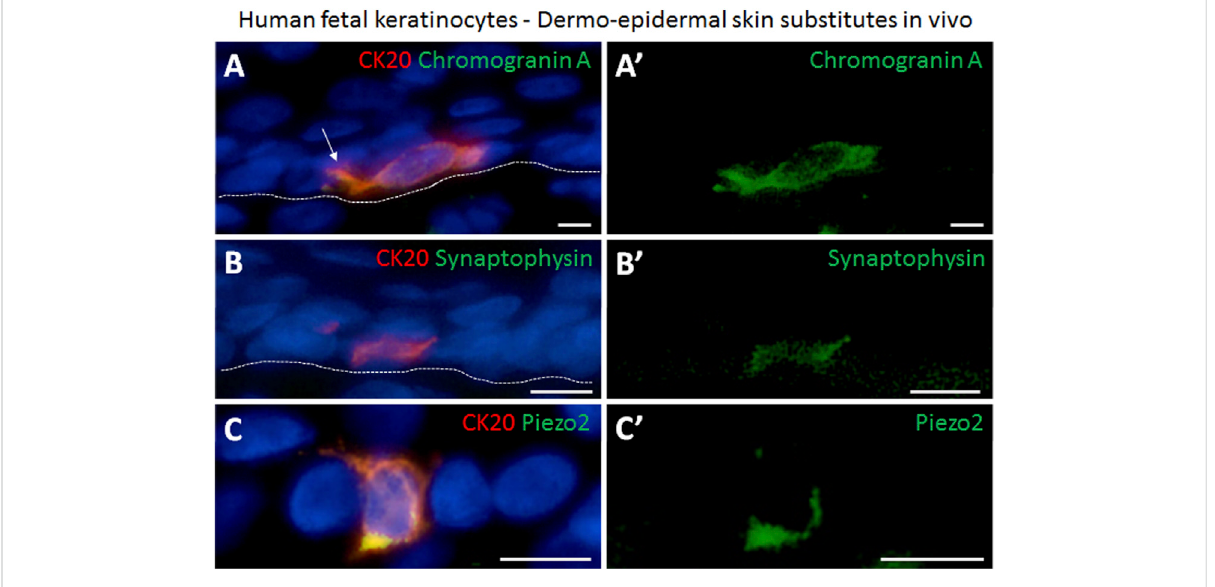
FIGURE 6 Immuno fl uorescence staining demonstrating the presence of neuroendocrine markers in human Merkel cells in dermo-epidermal skin substitutes 4 weeks after transplantation in an animal model. (A,A 9 ) Expression of CK20 (red) and chromogranin A (green). (A 9 ) single staining of chromogranin A (green) highlighting its presence in the CK20-positive Merkel cell in (A) . White arrow depicts dendritic protrusion of Merkel cell. (B,B 9 ) CK20 (red) and synaptophysin (green) expression. (B 9 ) staining of synaptophysin (green) demonstrating its presence in the CK20 positive Merkel cell in (B) . (C,C 9 ) Piezo2 (green) expression in CK20-positive (red) Merkel cell. (C 9 ) shows expression of Piezo2 in CK20-positive Merkel cell in (C) . Dashed white lines indicate locations of dermal-epidermal junctions. Hoechst 33342 (blue) was used to counterstain nuclei. Scale bars: 10 μ